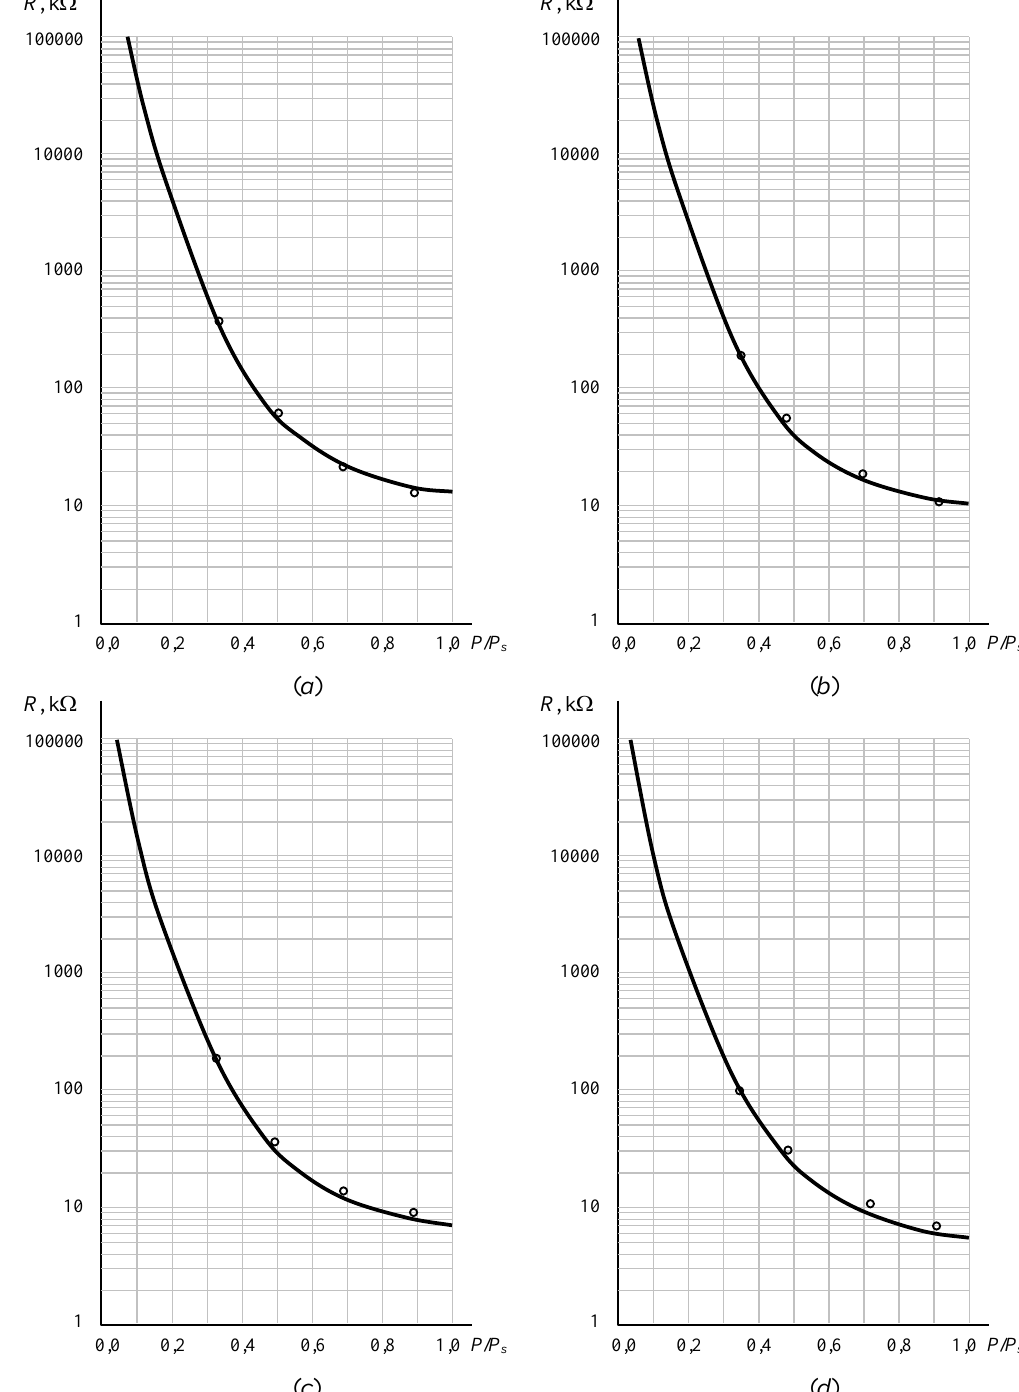
Fig. 1. The R ( P / P S ) dependence at various temperatures: ( a ) 15 ° C; ( b ) 20 ° C; ( c ) 30 ° C; ( d ) 40 °